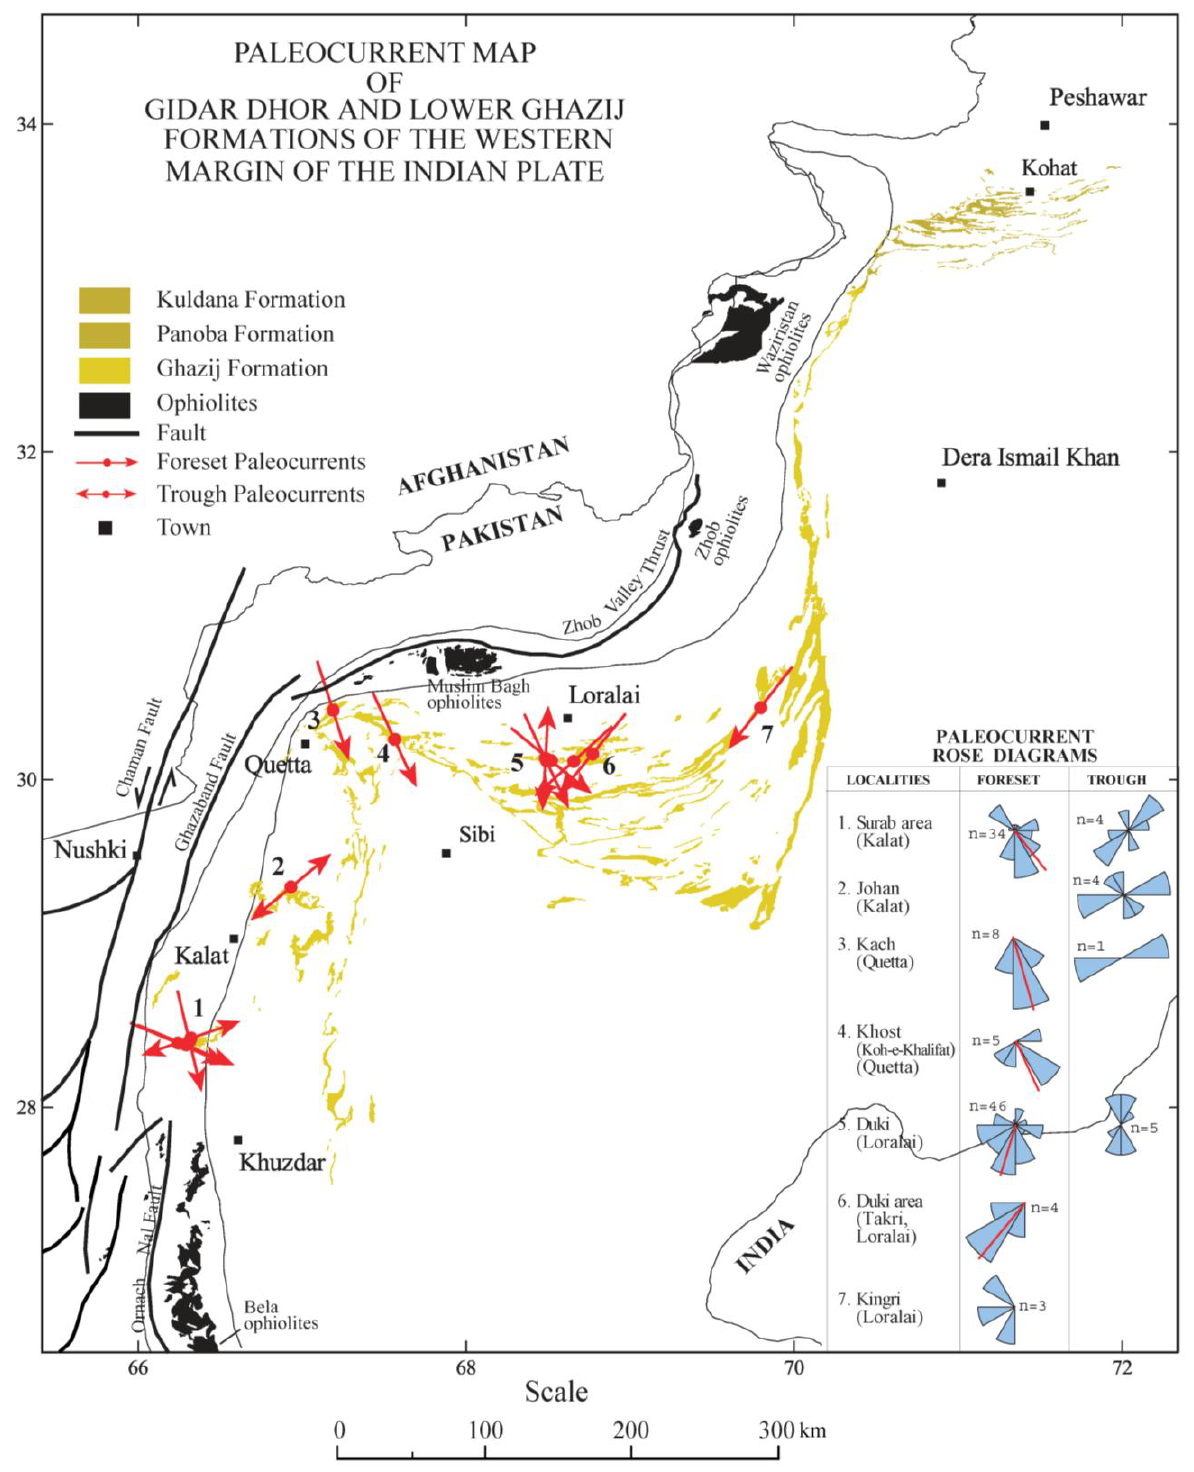
Figure A5. Paleocurrent map of Gidar Dhor and lower Ghazij Formations of the western margin of the Indian Plate showing dominant east-southeastward paleoflow during late Paleocene-early Eocene time. Prior to Paleocene time, the dominant paleoflow of sediments was to the west and